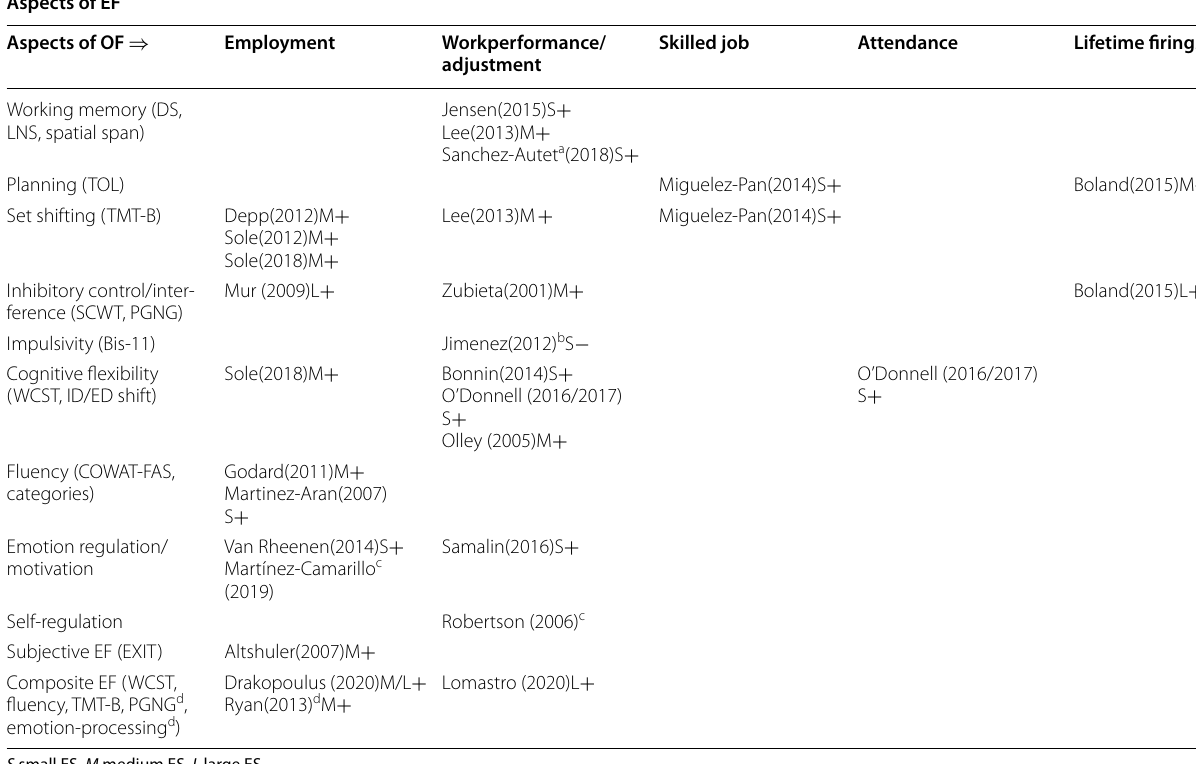
Table 4 Associations between EF and occupational